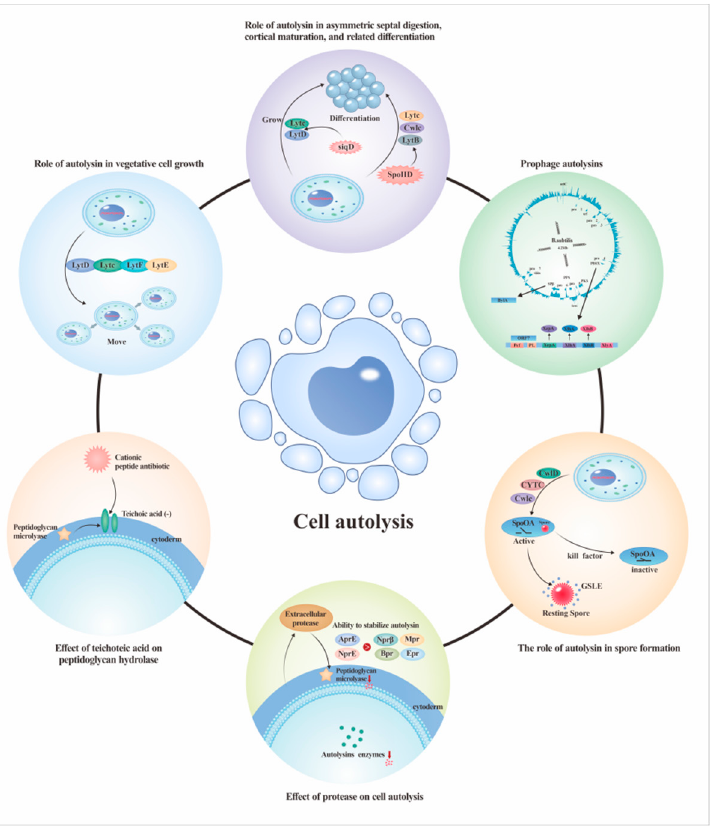
Figure 3. The role of key autolysis enzymes of B. subtilis in life processes and the factors affecting them.